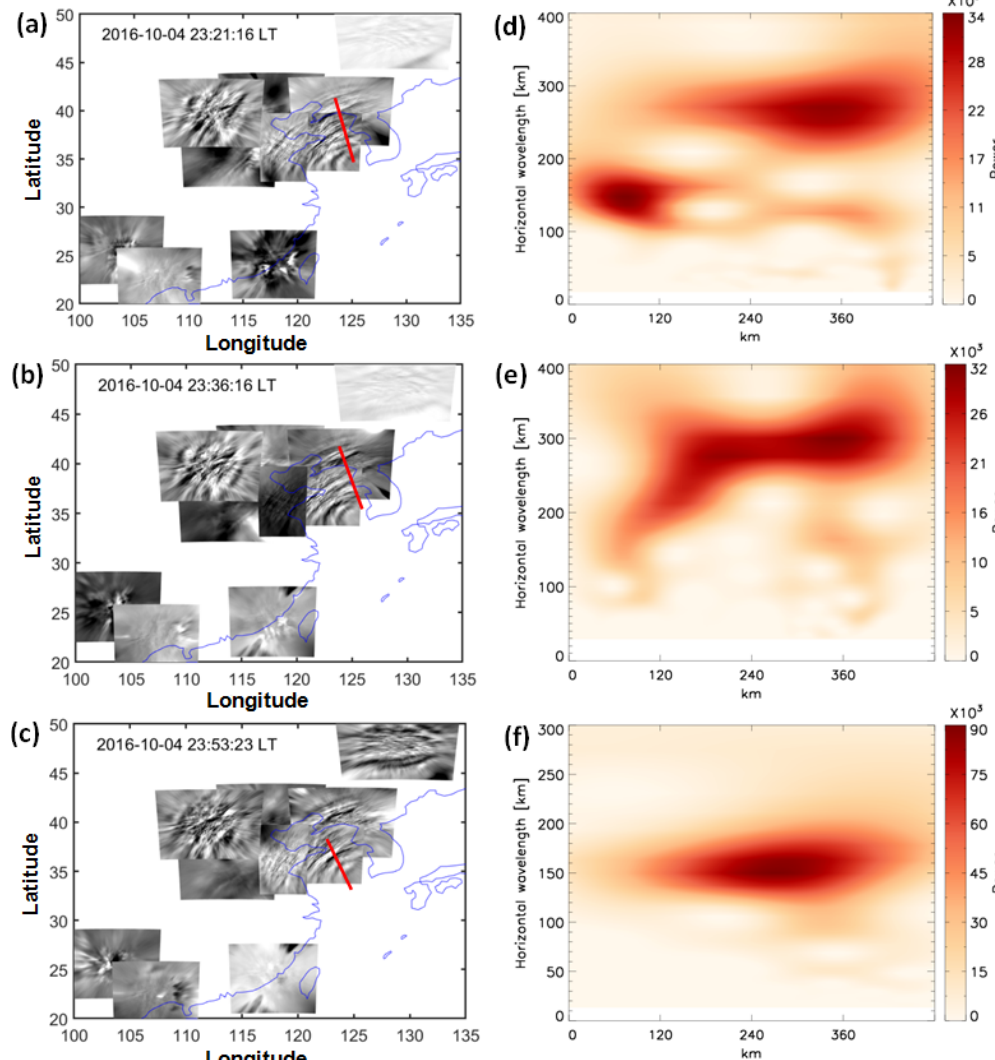
Figure 5. OH airglow emission perturbations induced by CGWs observed by the OH airglow imager network at (a) 23:21LT, (b) 23:36LT, and (c) 23:53LT on 4 October 2016. (d) Wavelet power spectrum along the red line in (a) , (e) wavelet power spectrum along the red line in (b) , and (f) wavelet power spectrum along the red line in (c)